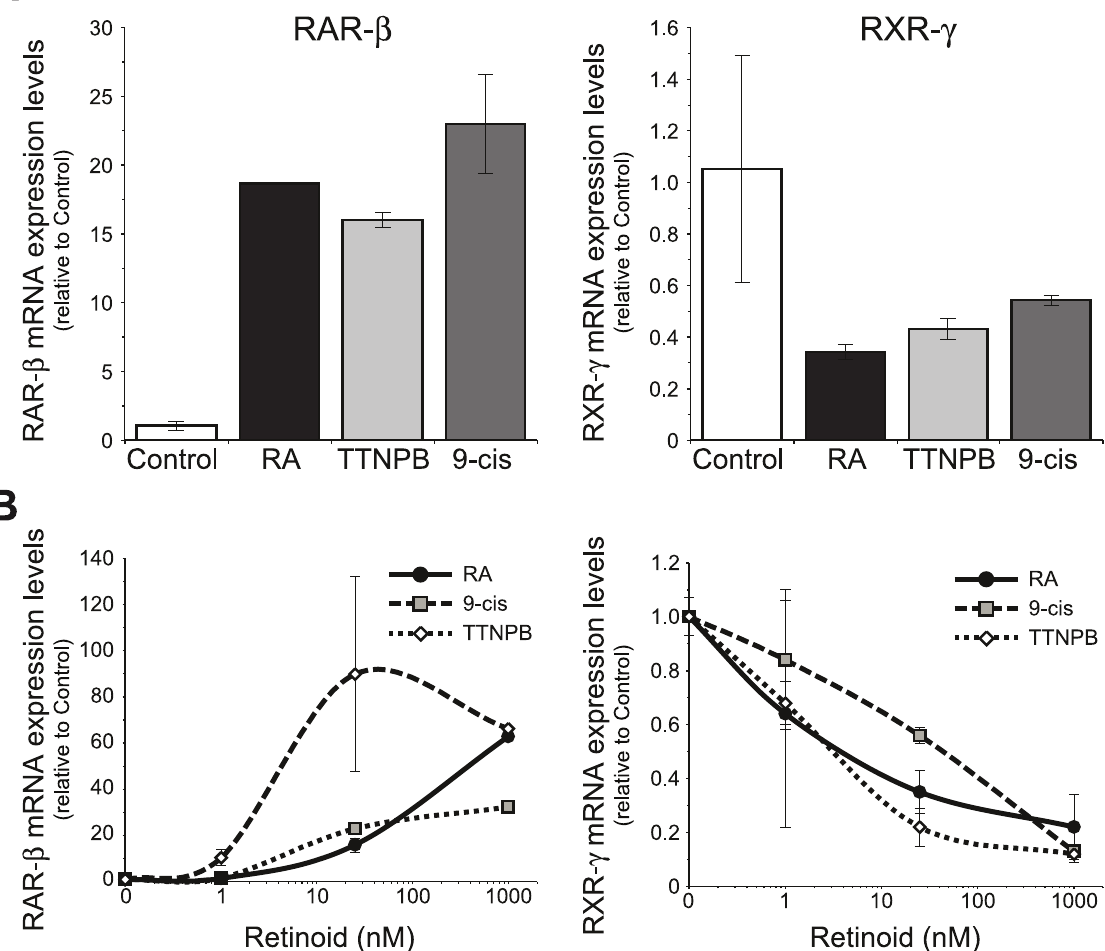
Figure 7. RAR- b and RXR- c regulation is mediated by RAR. ( A ) Myelinating cocultures were treated for 7 days with 1 m M of the natural retinoids all-trans -retinoic acid (RA) and 9-cis -retinoic acid ( 9-cis ), or the synthetic compound TTNPB, and the relative mRNA levels of RAR- b and RXR- c were determined by RT-Q-PCR. ( B ) Isolated SCs were treated for 48 hours with different doses of all-trans -retinoic acid (RA), TTNPB or 9-cis -retinoic acid ( 9-cis ), and the relative levels of RAR- b and RXR- c mRNAs were determined by RT-Q-PCR. All values are shown as the mean 6 SD relative to their respective controls.